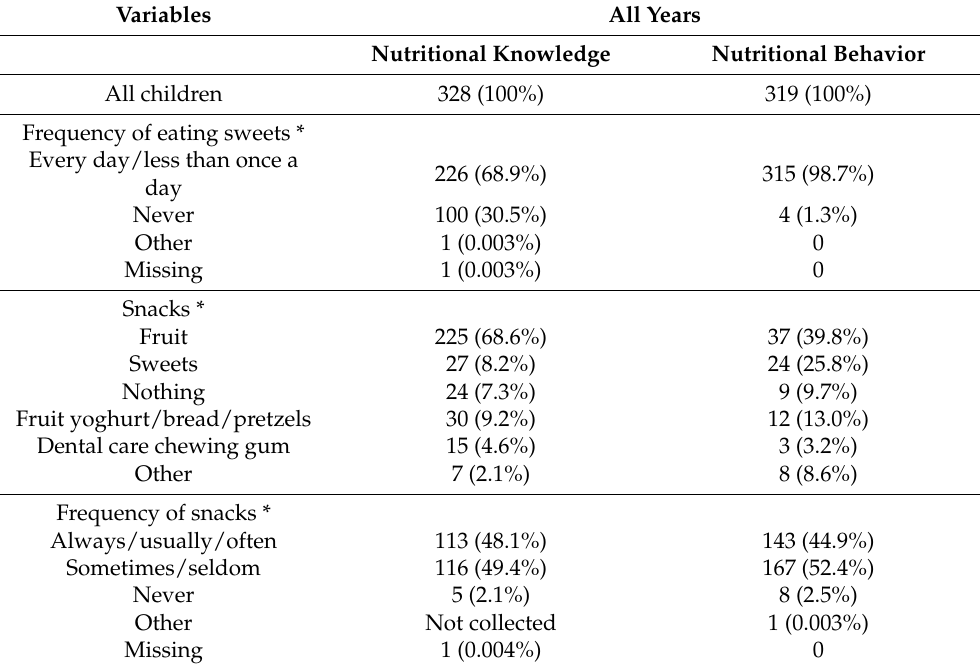
Table 1. Summary of responses. Correlation analysis across all results with Pearson correlation (knowledge correlated against behavior) was made and a significant (*) correlation was found ( p <